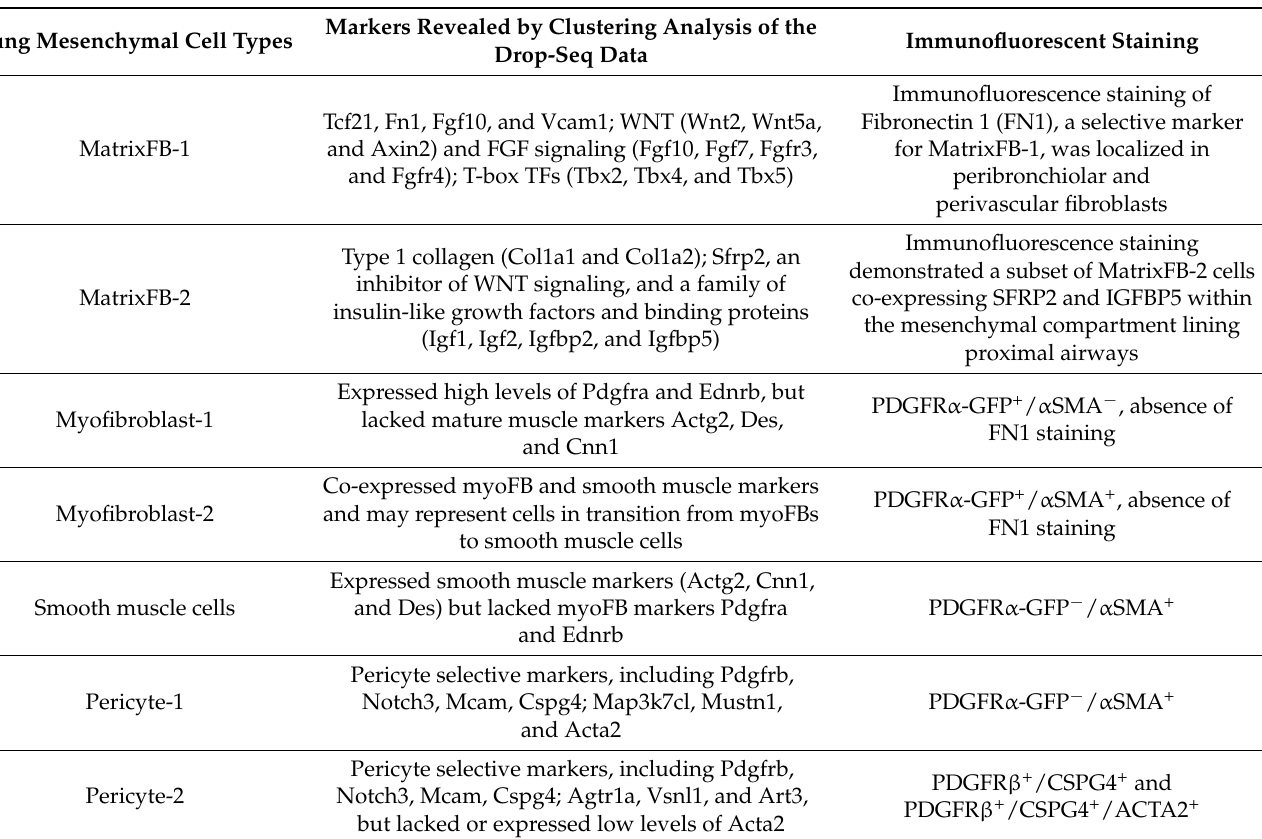
Table 2. Markers which expression gradients were used by [92] to isolate certain subpopulations of mesenchymal cells, and immunofluorescent staining for markers, which the authors used to identify these populations in mouse lung (presumably on